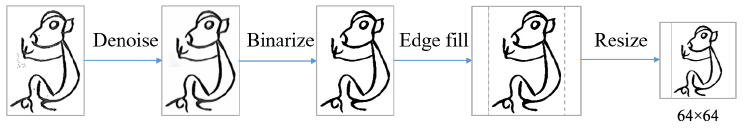
Figure 3. The preprocessing process of OBI character “ monkey